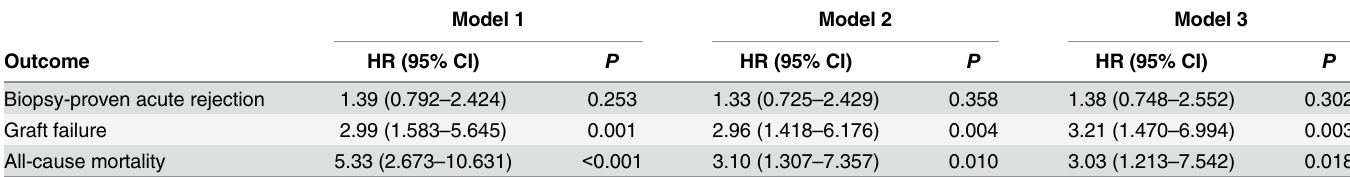
Table 2. Hazard ratios for post-transplant outcomes in the hyponatremia group compared with the normonatremia group.